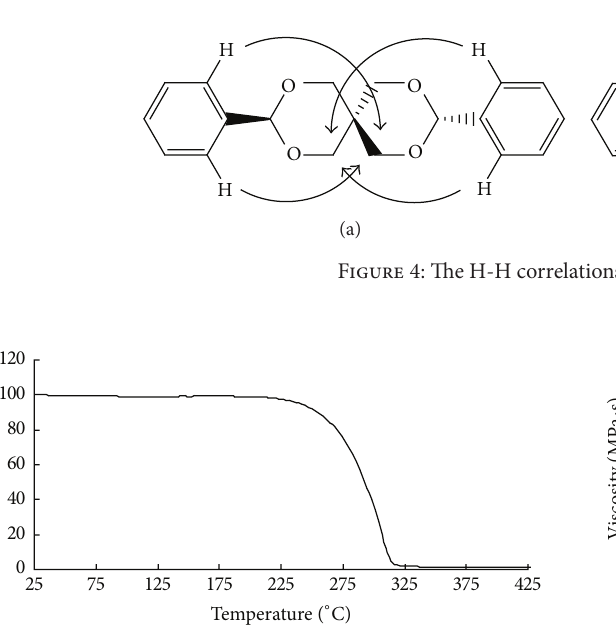
Figure 5: The TGA curves of 3,9-diphenyl-2,4,8,10-tetraoxa- spiro[5.5]undecane.